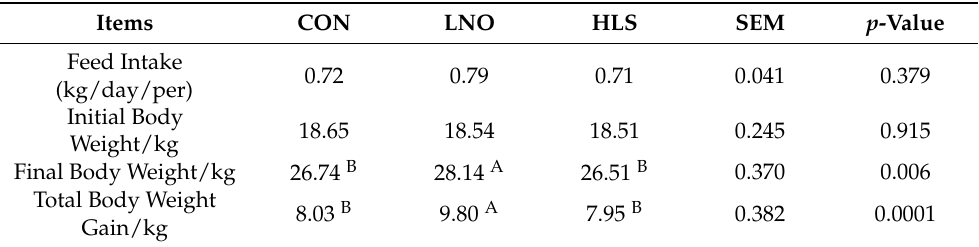
Table 2. The effect of dietary flaxseed oil or flaxseed supplementation on the growth performance in Albas cashmere goats.